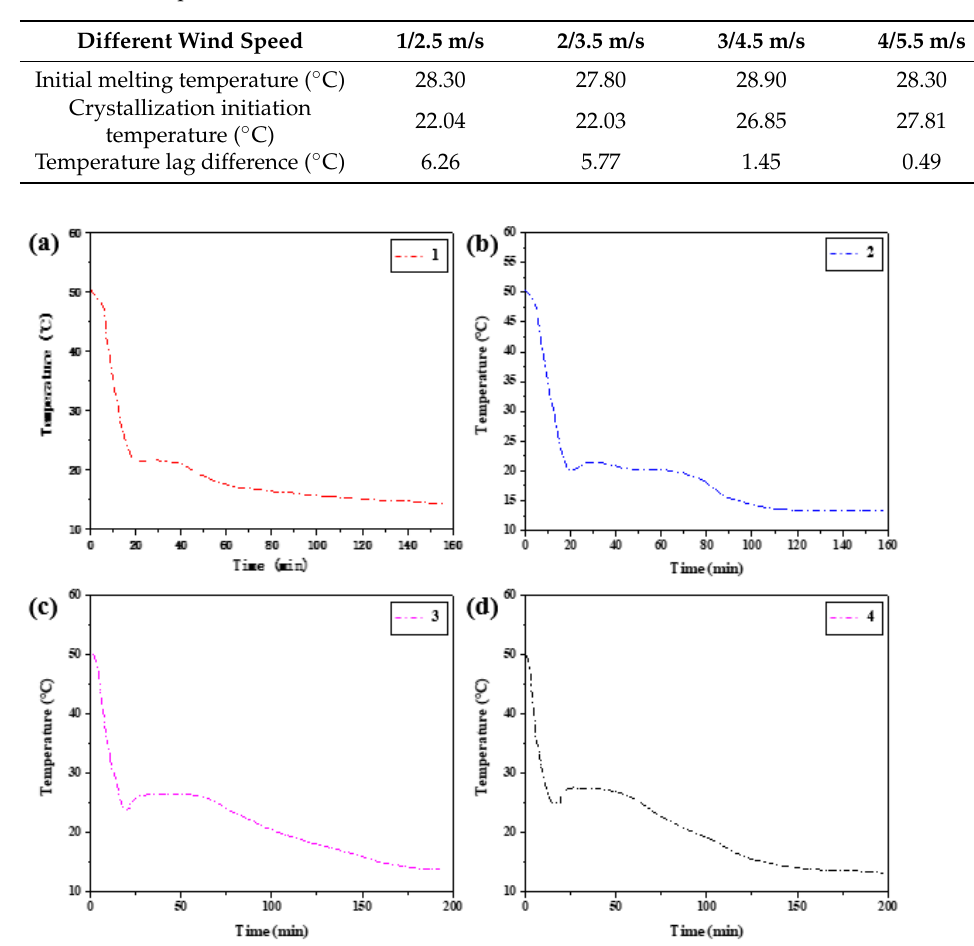
Figure 13. ( a ) Physical drawing of adjustable speed experimental fan. ( b ) Anemometer.